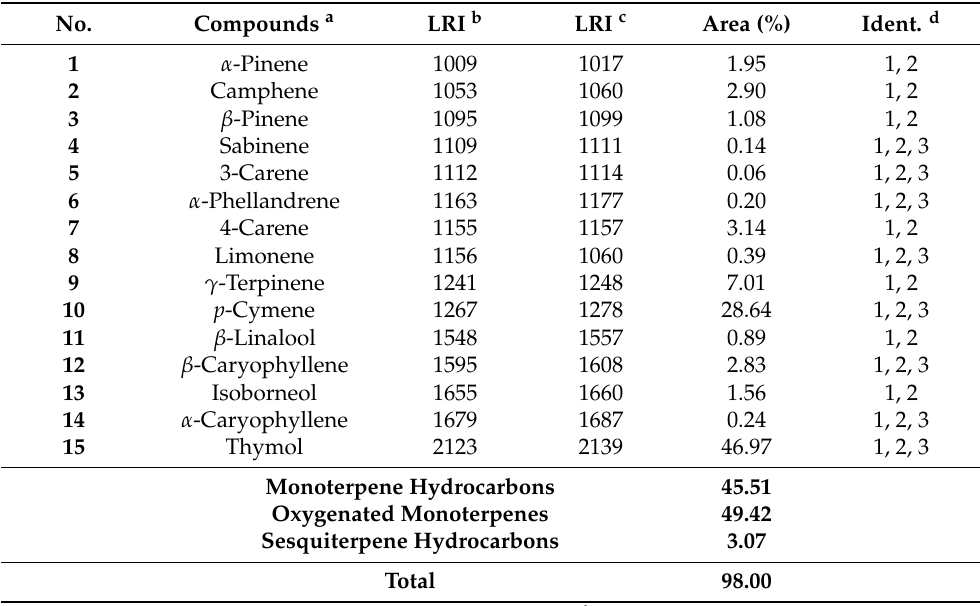
Table 1. Chemical composition of Thymus leucotrichus var. creticus essential oil collected in Greece. No. Compounds a LRI b LRI c Area (%) Ident. d α -Pinene